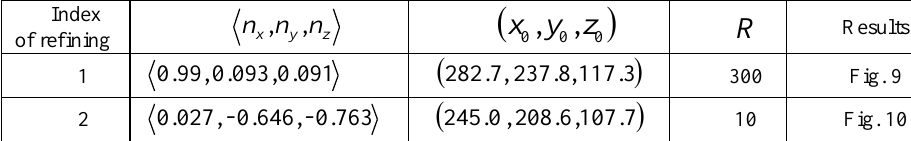
Table 1. Parameter setting in the refinings of our